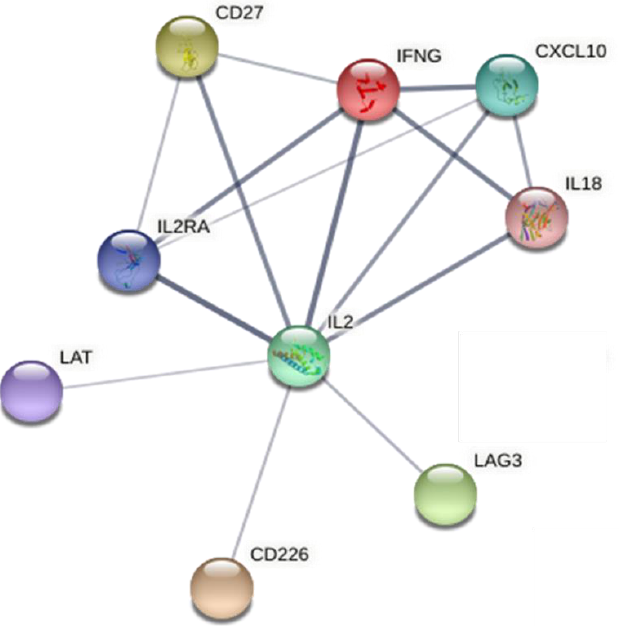
Figure 3. Interaction of top ten enriched immune proteins in BanLec stimulated porcine PBMC secretome, analyzed by open source software String version 11.0.